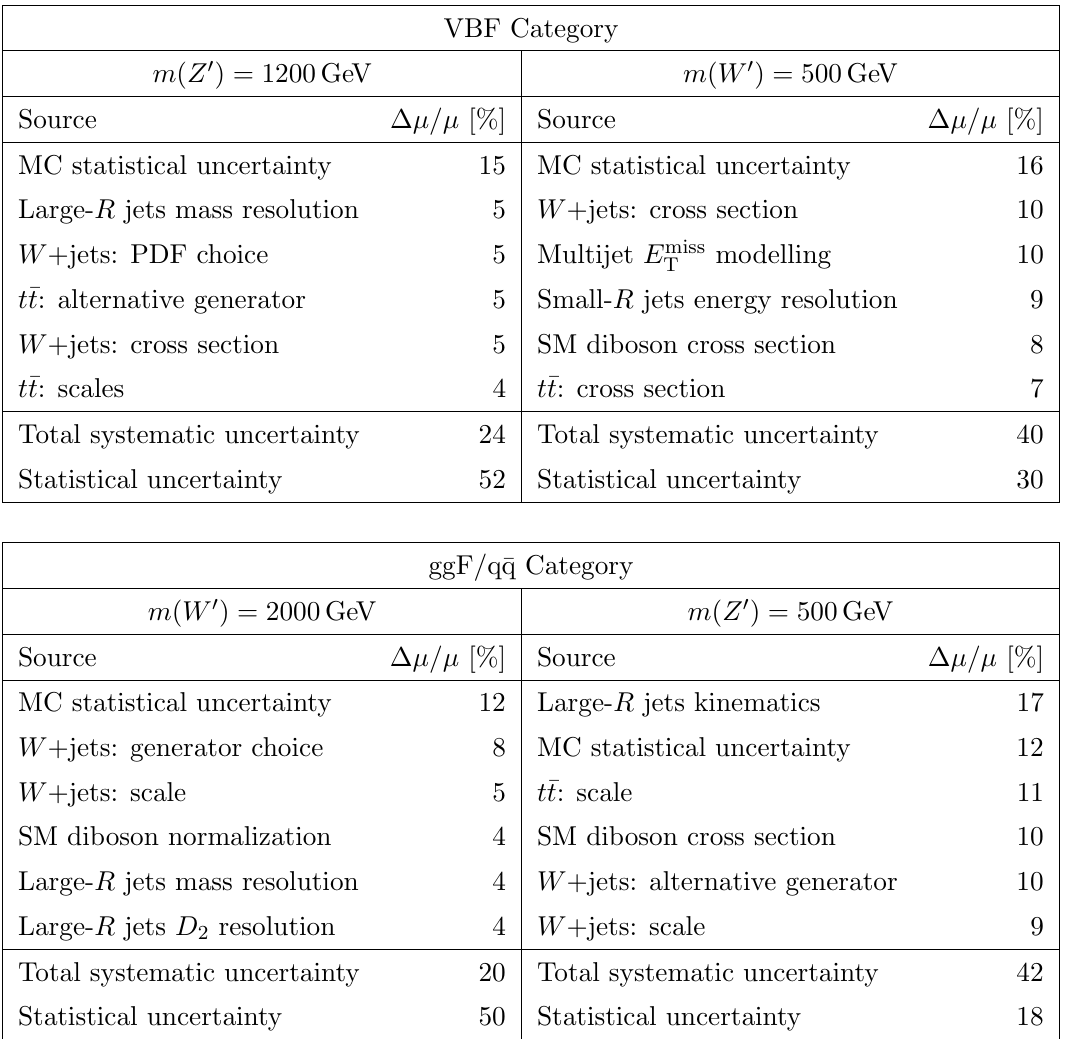
Table 4 . Dominant relative uncertainties in the signal-strength parameter ( (cid:22) ) of hypothesized HVT signal production with m ( Z 0 ) = 1200 GeV and m ( W 0 ) = 500 GeV in the VBF category, and m ( W 0 ) = 2000 GeV and m ( Z 0 ) = 500 GeV in the ggF = q(cid:22)q category, assuming that the